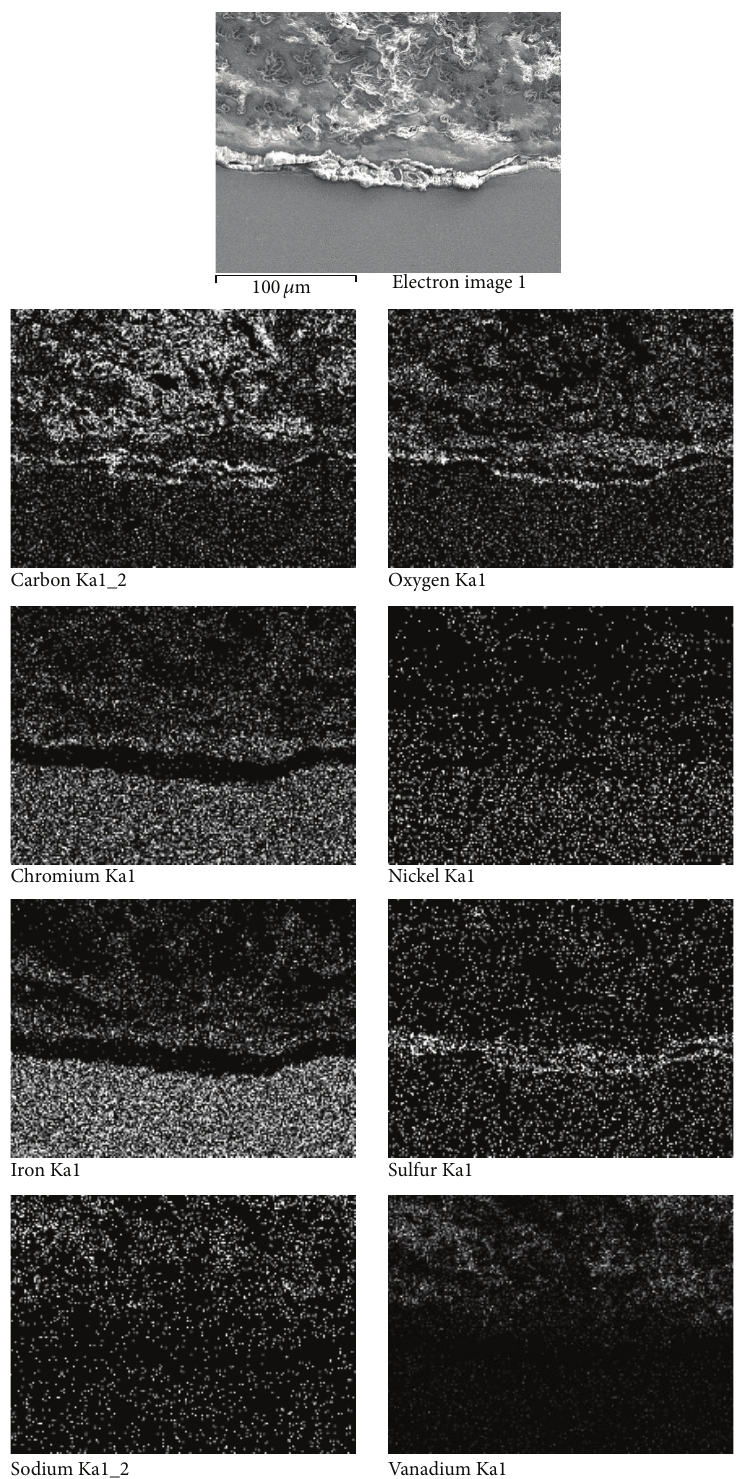
Figure 1: Energy dispersive X-ray maps of cross sections of stainless steel 309 after immersion tests in 50 mol% V 2 O 5 -50 mol% Na 2 SO 4 at 700 ∘